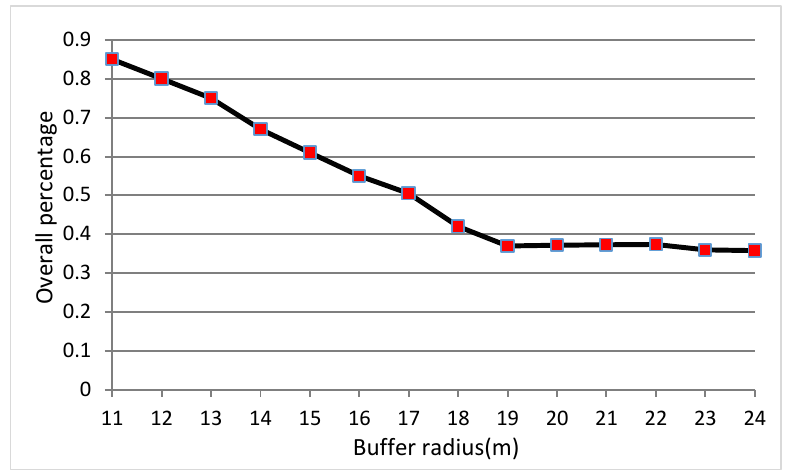
Figure 4. Overall percentage of Equation (1) in a 5 km × 5 km